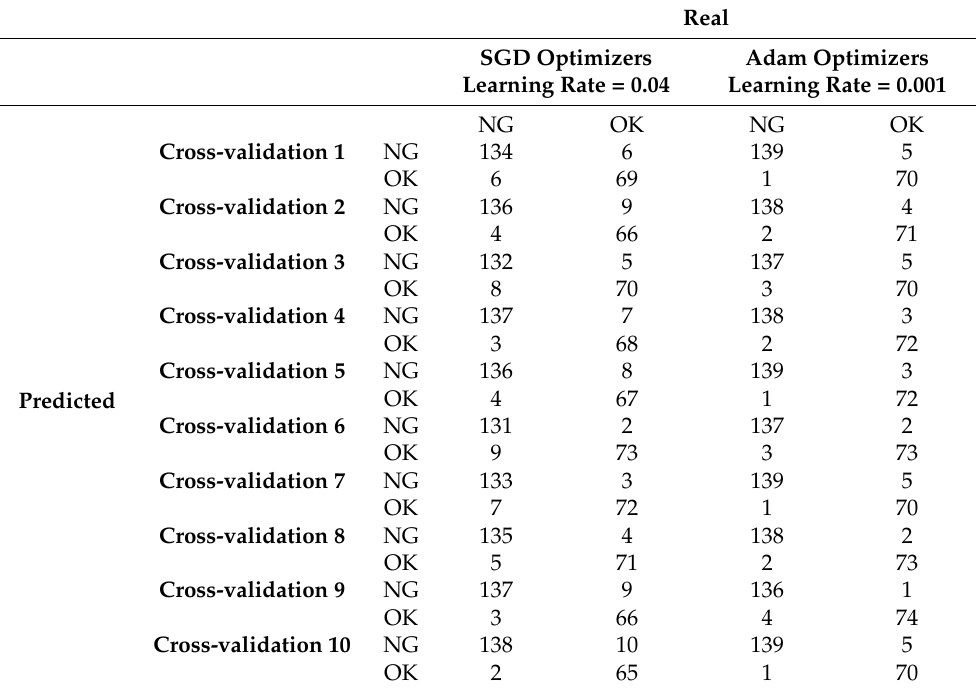
Table 1. Confusion matrix of ten different cross-validations for SGD optimizers with learning rate 0.04 and Adam optimizers with learning rate 0.001.